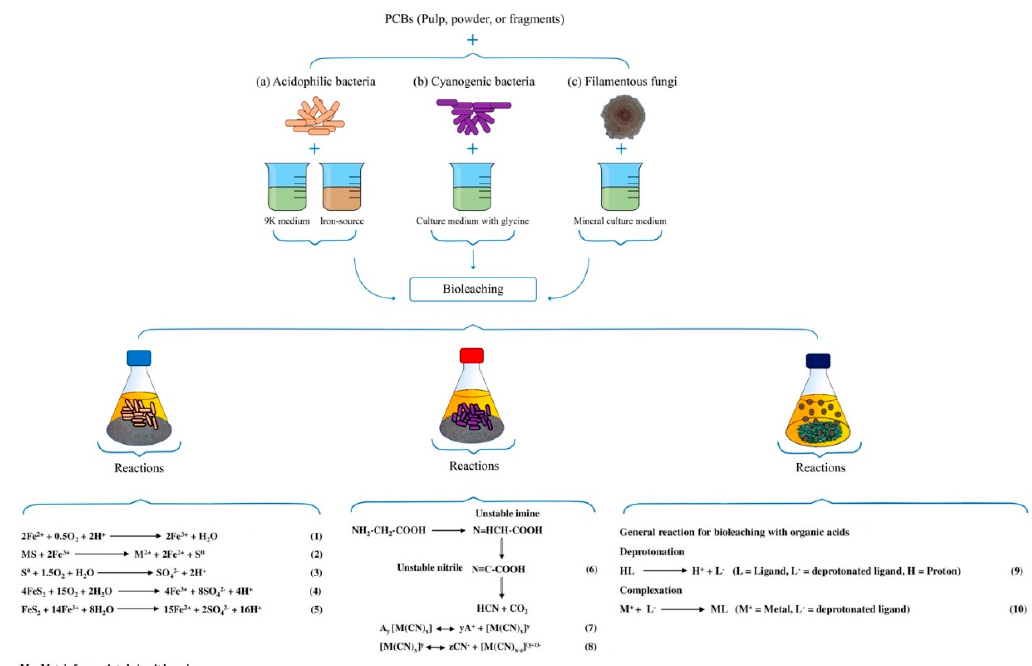
Figure 3. Bioleaching process. ( a ) Acidophilic bacteria: The mechanism of these bacteria to mobilize metals from PCBs is through the oxidation of ferrous iron to ferric iron (Equation (1)) as a strong oxidizing and the oxidation of elemental sulfhur to produce sulfhuric acid (Equation (3)). The bacterial-generated ferric iron can leach metal sulfhides such as chalcocite (Cu 2 S) (Equation (2)) or pyrite (FeS 2 ) (Equations (4) and (5)) in an acidic medium [55]. In the bioleaching processes, in order to extract metals from PCBs, ferrous iron sulfate, elemental sulfur, biogenic sulfur, and pyrite have been used as an energy source for bacteria [66]. ( b ) Cyanogenic bacteria: The pathway of the production of bacterial cyanide from glycine has three steps. In the first step, glycine is transformed into an unstable imine by the action of glycine oxidase; in step two, the unstable imine is transformed into a highly unstable nitrile by the action of the dehydrogenases associated with the respiratory system [38,73]; and in step three, the unstable nitrile is transformed into hydrocyanic acid (HCN) through a non-enzymatic step (Equation (6)). Metal cyanides composed of metal atoms and one or more cyanide ions are represented by the formula Ay[M (CN) x ], where A is an alkali, alkaline earth, or heavy metal, and M is typically a transition metal. They are able to form a transition metal cyanide complex (Equation (7)), which may release cyanide ions via further dissociation (Equation (8)) [39]. ( c ) Filamentous fungi: Organic acids play an important role in accelerating the detachment of metals from the surface of the PCBs [42]. Bioleaching in which organic acids are involved is mainly based on the deprotonation (Equation (9)) reaction and the formation of metal complexes (Equation (10)) [40]. It is worth mentioning that the participation of citric acid, oxalic acid, malic acid, and gluconic acid has been frequently reported for this bioleaching process.